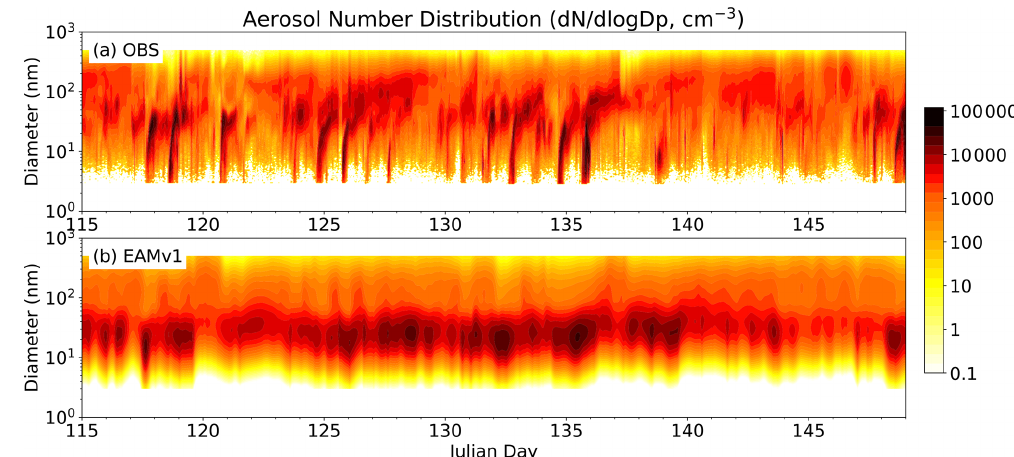
Figure 11. Time series of (a) observed and (b) simulated surface aerosol number distribution during HI-SCALE IOP1. The observed aerosol number distribution is from merged nanoSMPS and SMPS data. Model data are cut off at 500nm for comparison with observations.